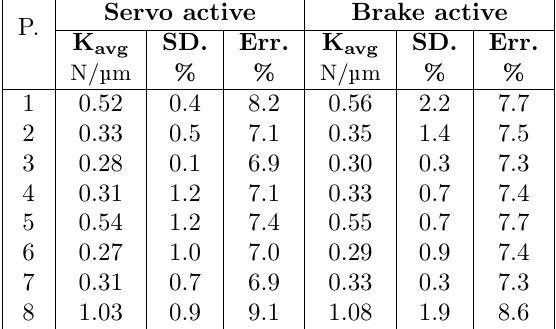
Table 11: 6-DOF Industrial Robot: average stiffness at locations in Fig. 12 with and without brakes